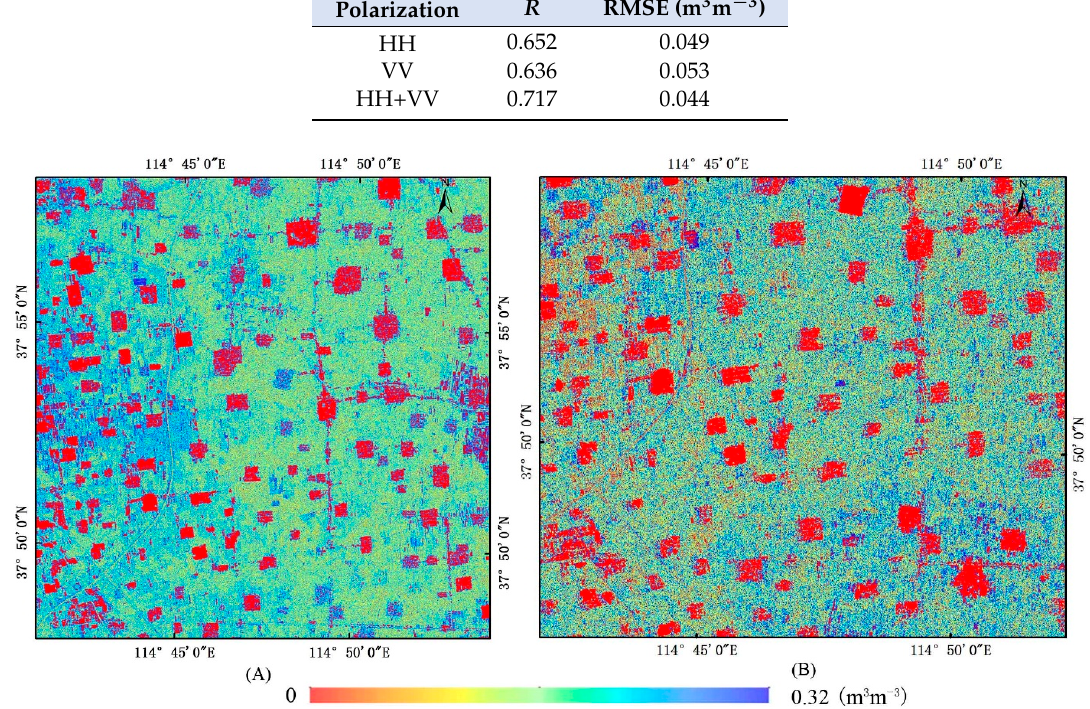
Figure 10. Retrieved soil moisture content map from the GF-3 satellite based on HH+VV backscatter (( A ) wheat in the filling stage, ( B ) corn in jointing stage).